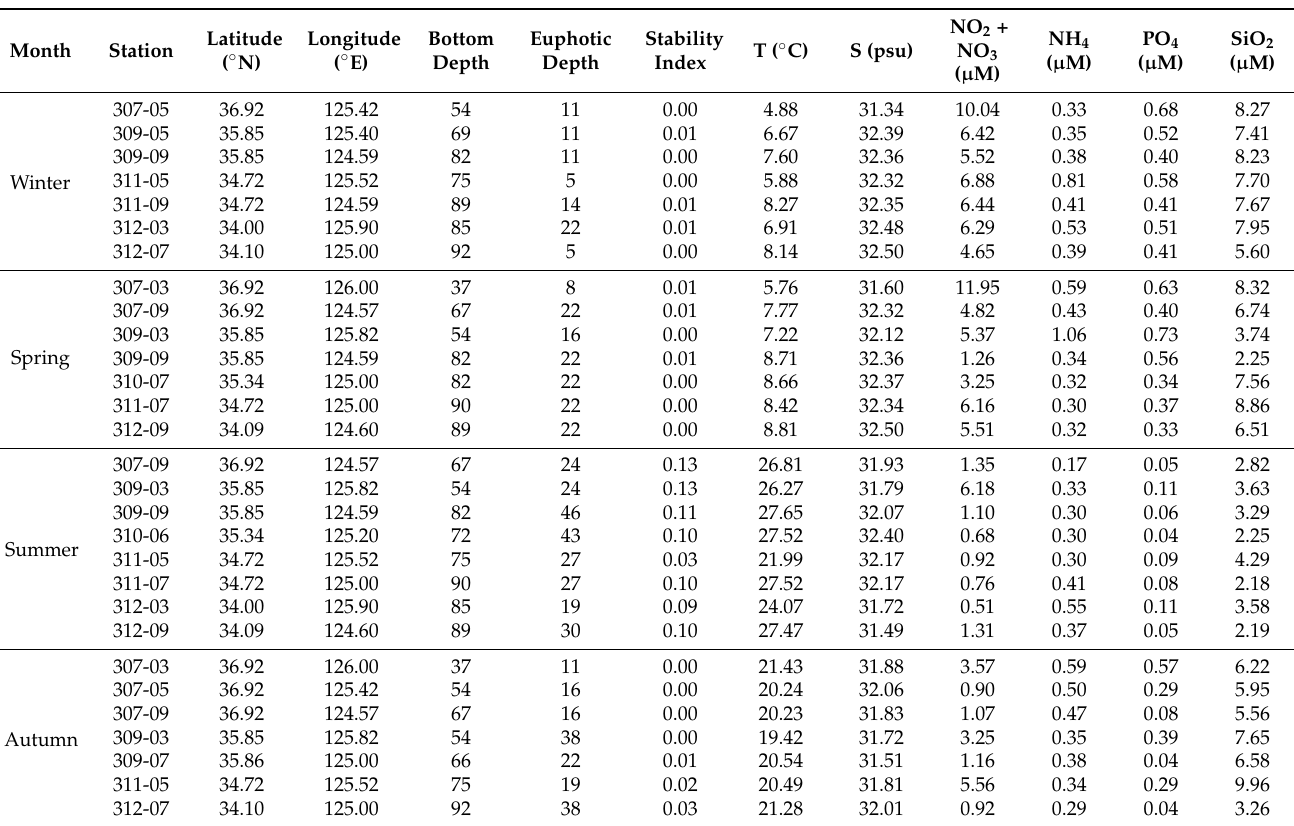
Table 1. Sampling locations and environmental parameters of the study sites in the YS,